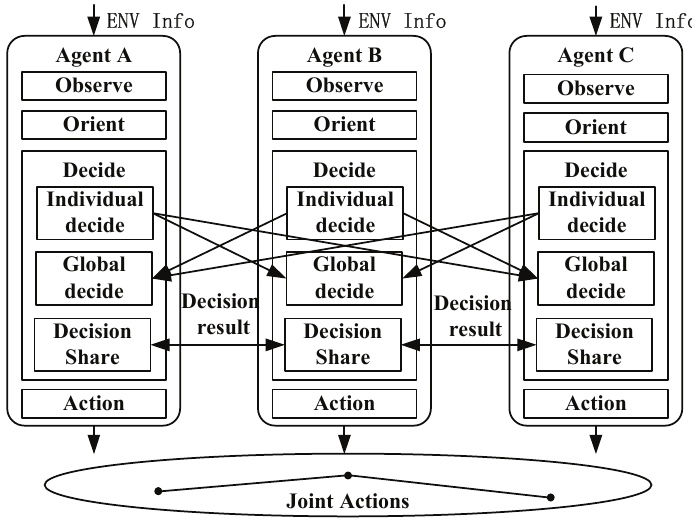
Figure 2. Decentralized multi-agent-based coordination in interception